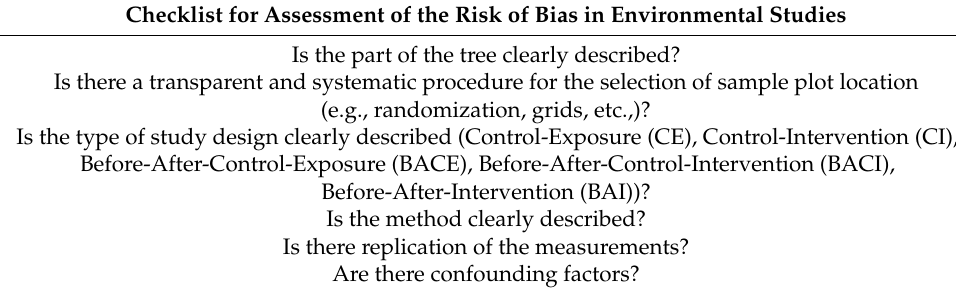
Table 7. Checklist for assessment of the risk of bias in environmental studies [18,19]. Checklist for Assessment of the Risk of Bias in Environmental Studies Is the part of the tree clearly described? Is there a transparent and systematic procedure for the selection of sample plot location (e.g., randomization, grids, etc.,)? Is the type of study design clearly described (Control-Exposure (CE), Control-Intervention (CI), Before-After-Control-Exposure (BACE), Before-After-Control-Intervention (BACI), Before-After-Intervention (BAI))? Is the method clearly described? Is there replication of the measurements? Are there confounding